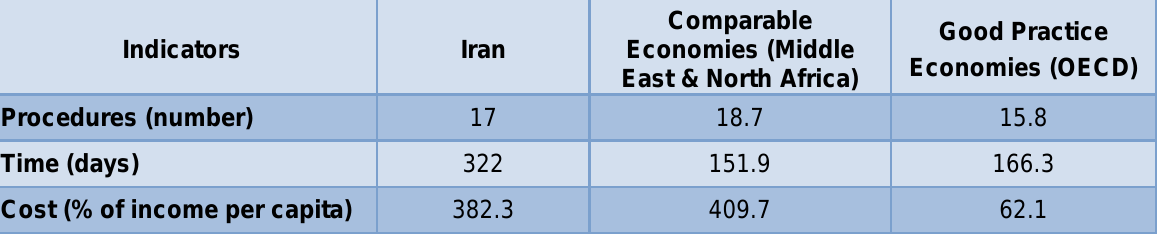
Table 1 Dealing with construction permits and other formal requirements (Source: The World Bank and the International Finance